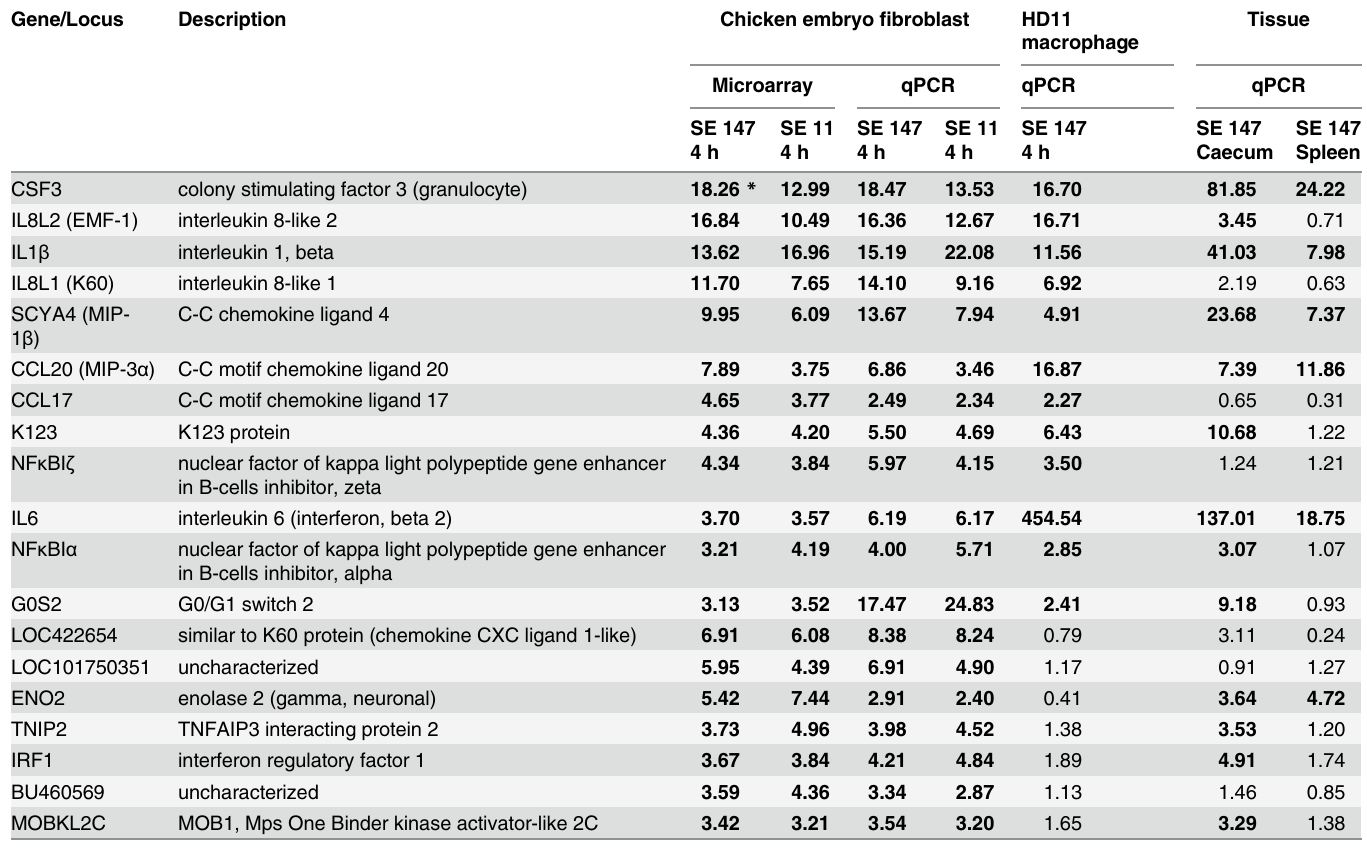
Values in the table represent fold inductions to appropriate non-infected control. * Bold numbers represent fold inductions higher than twofold and signi fi cantly different from non-infected controls at p <